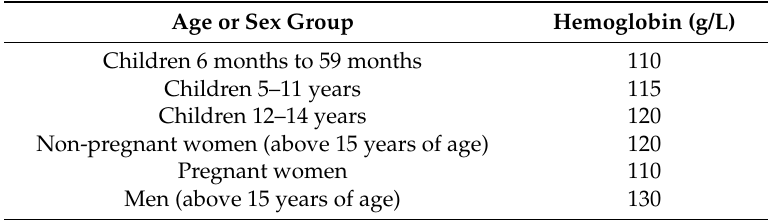
Table 1. Hemoglobin cutoffs used to define anemia in people living at sea level.